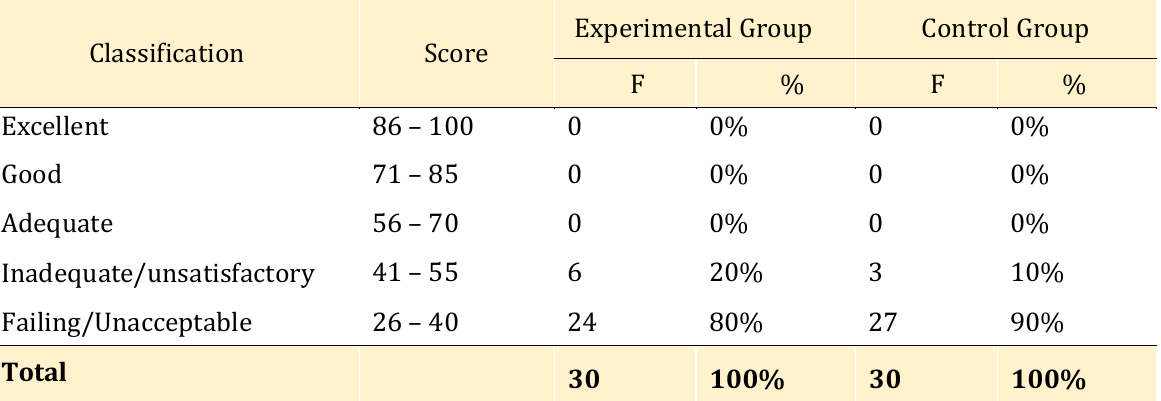
Table 3. The Frequency and Percentage of Students’ Achievement in term